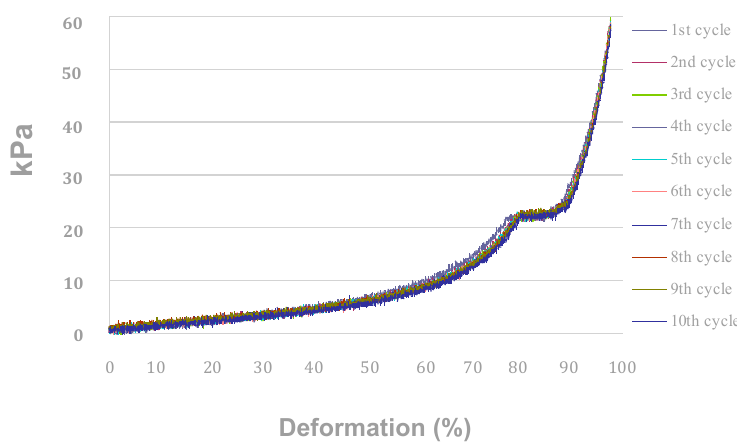
Figure 6. Compression traces of the wool fibril sponges in the wet state after 21 days of culture in MM with cells and PEMF. Similar behavior was obtained for all other conditions tested.